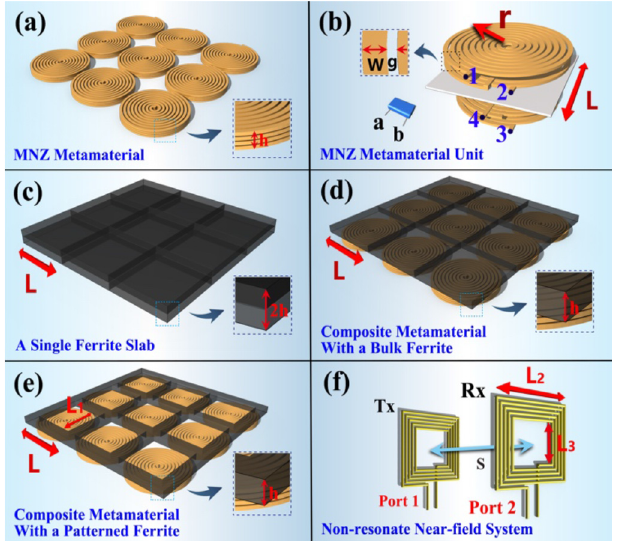
Fig. 1. The schematic diagram of the experimental samples. (a) MNZ media, the total thickness is h . (b) MNZ metamaterial unit. The side length of the unit is L , and the radius of each single disc is r . The width of the copper is w , the gap is g . The pin a and b of the capacitor is connected to the terminal 2 and 3 by soldering, respectively, and the other terminal 1 is connected to the terminal 4. (c) A single ferrite slab. The side length of each bulk is L . The thickness of the slab is 2 h . (d) Composite metamaterials with a bulk ferrite. For each ferrite bulk, the side length is L , the thickness is h . (e) Composite metamaterials with a patterned ferrite. For patterned ferrite, the outer length is L , the inner length L 1 , and the thickness is h . (f) Non-resonant system. The Tx coil is the same as the Rx coil, the outer length is L 2 , the inner length is L 3 . The distance between them is S .